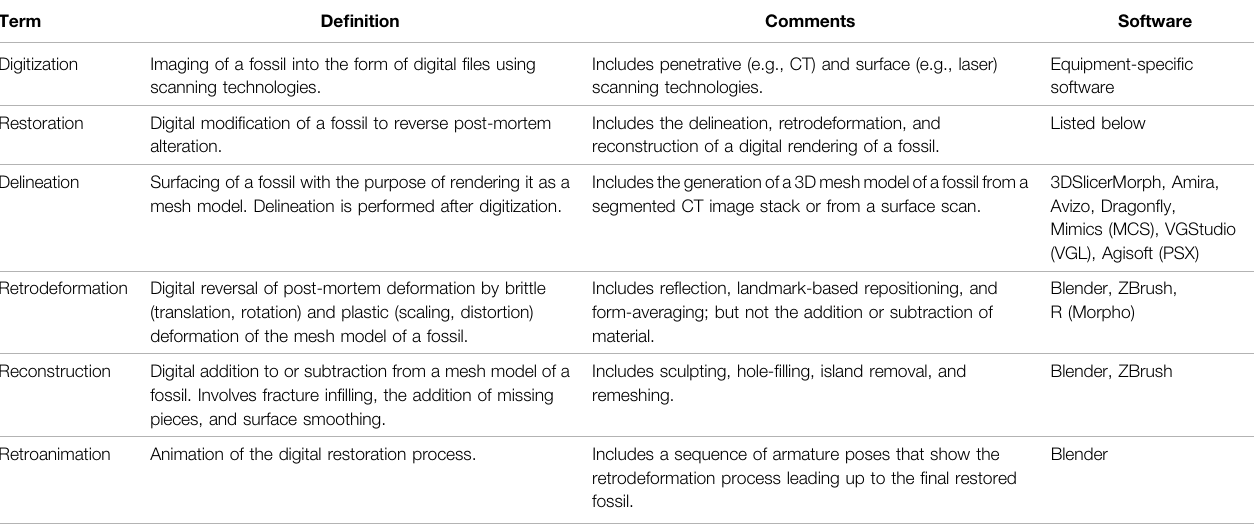
TABLE 1 | De fi nition of terms used in this paper for the process of digital restoration of a